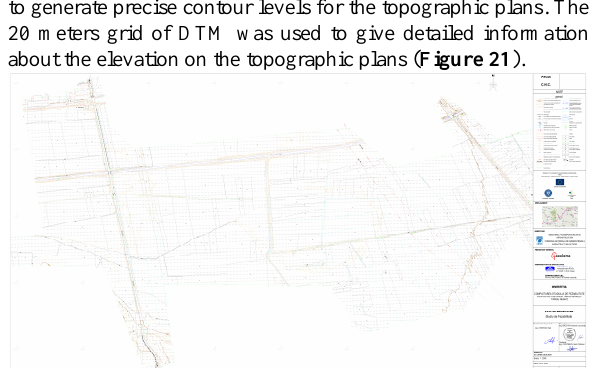
Figure 21 . Topographic plans with 20m DTM support and level curves generated on the DTM grid at 1m from LiDAR data